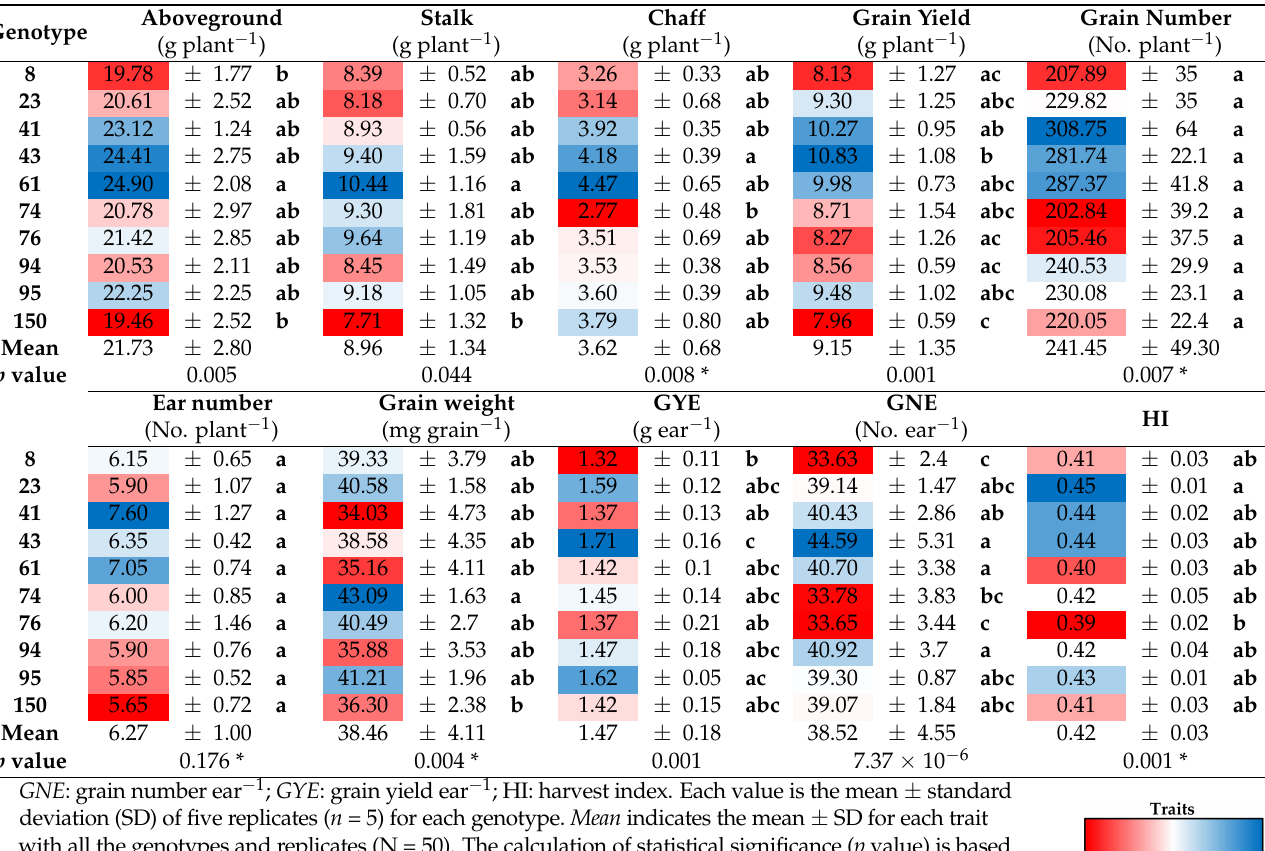
Table 1. Production (aboveground, stalk and chaff biomasses) and grain yield components (grain yield, grain number, ear number, grain weight, grain yield per ear, grain number per ear, and harvest index) of 10 wheat genotypes grown under elevated CO 2 and high temperature.